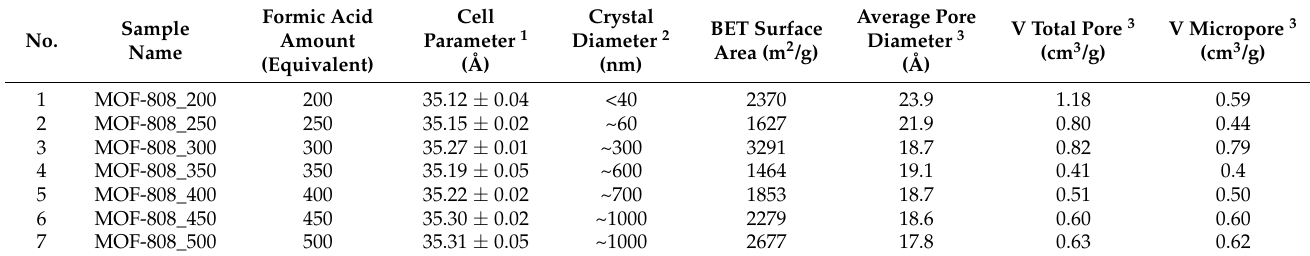
Figure 3. SEM images of MOF-808 synthesized with different amounts of formic acid. Table 2. Characteristic properties of MOF-808 synthesized with various amounts of formic acid.